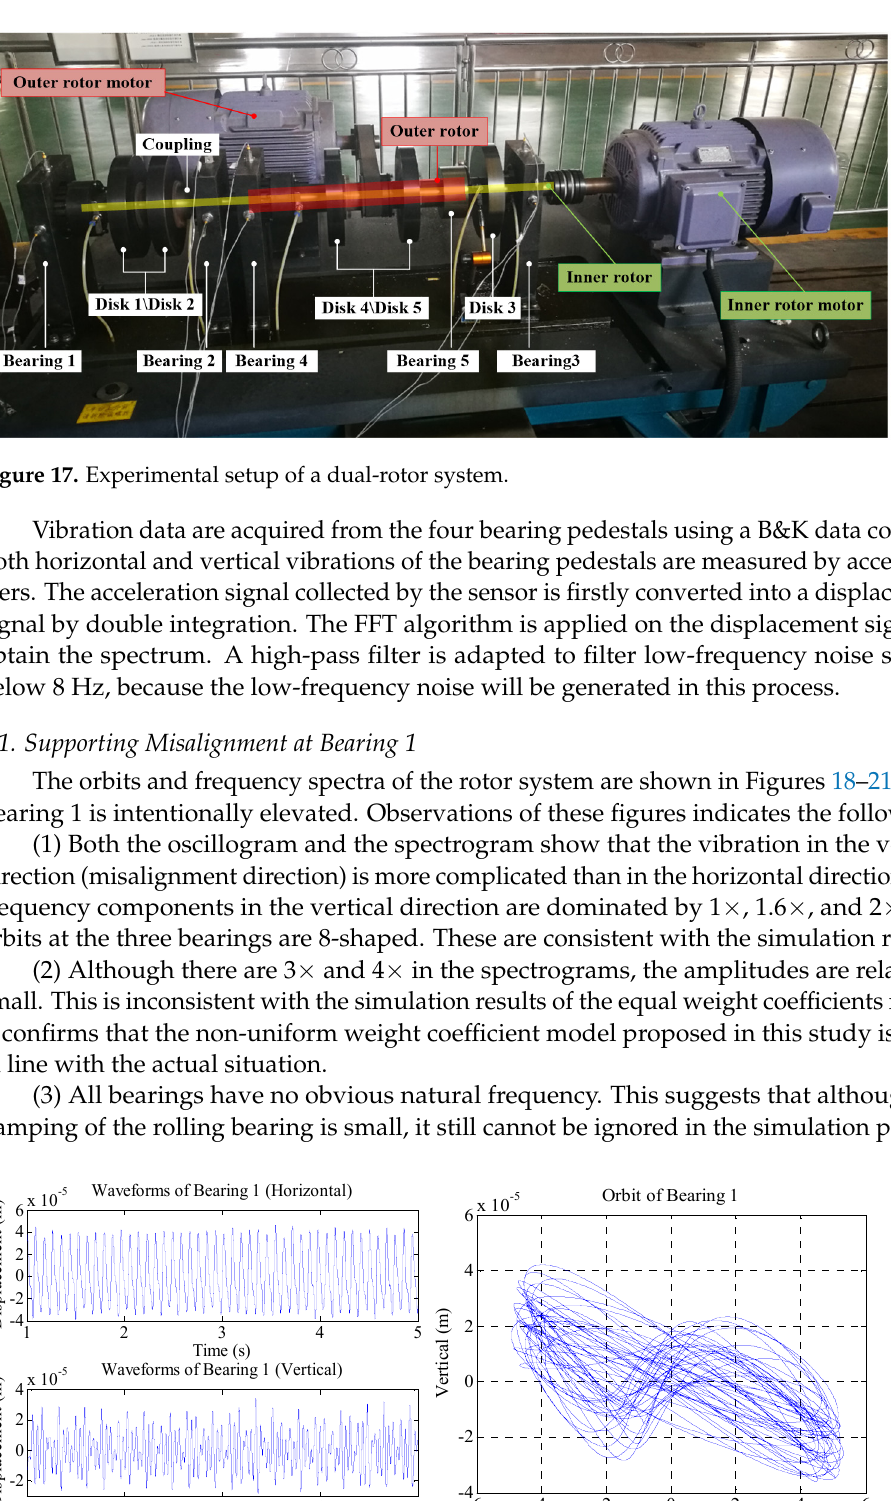
Figure 19. The spectrum of horizontal and vertical direction of Bearing 1. Figure 20. The spectrum and the orbit of Bearing 3. 0